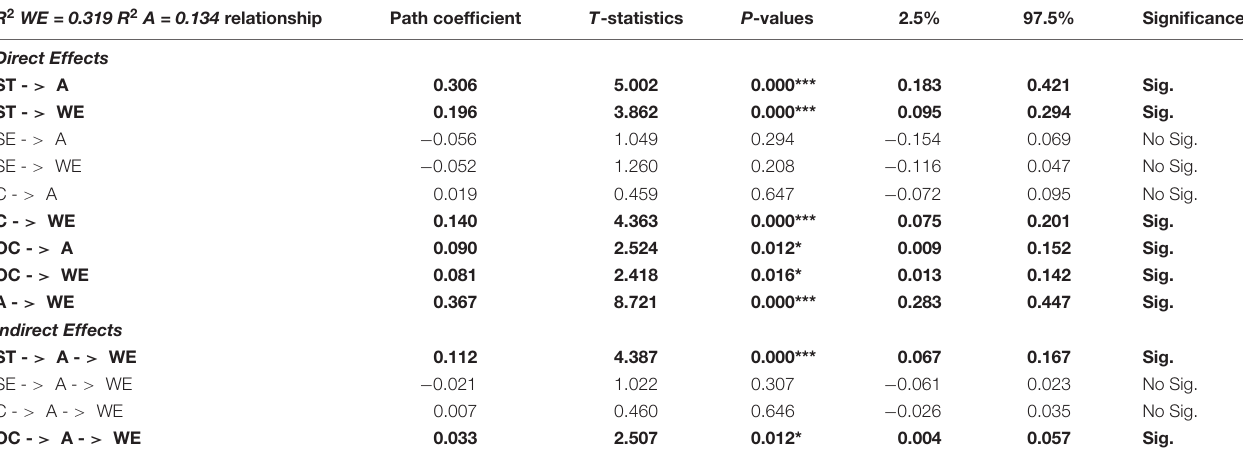
TABLE 5 | Structural